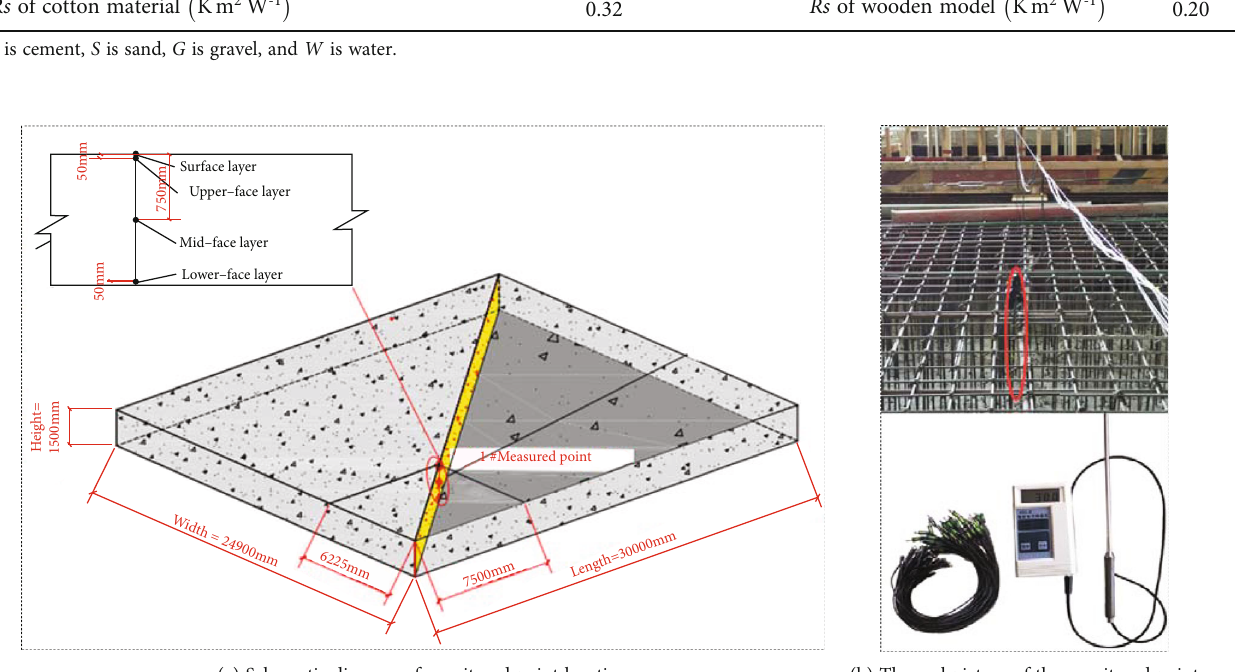
Figure 2: Measured points in concrete structure (unit: